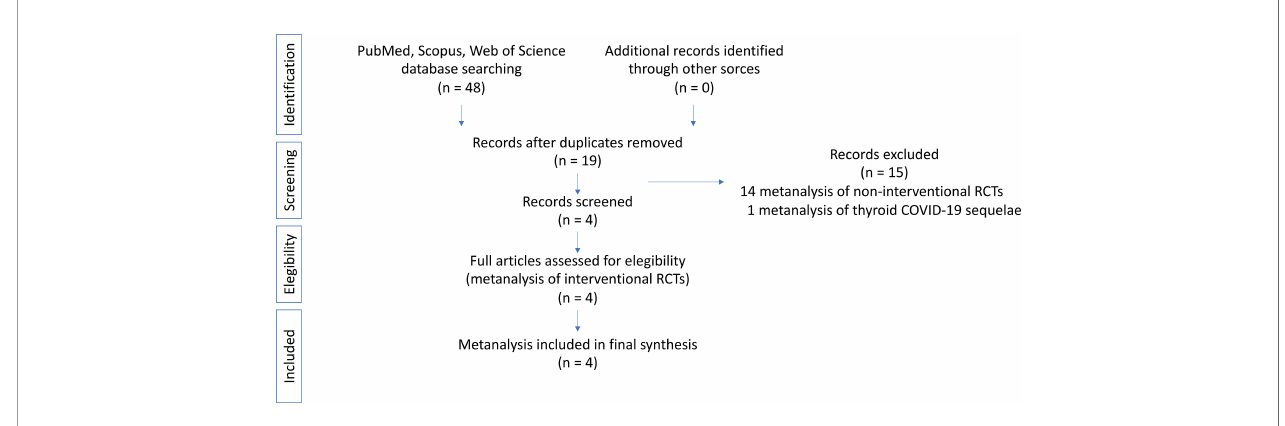
FIGURE 1 | Search strategy and fl ow